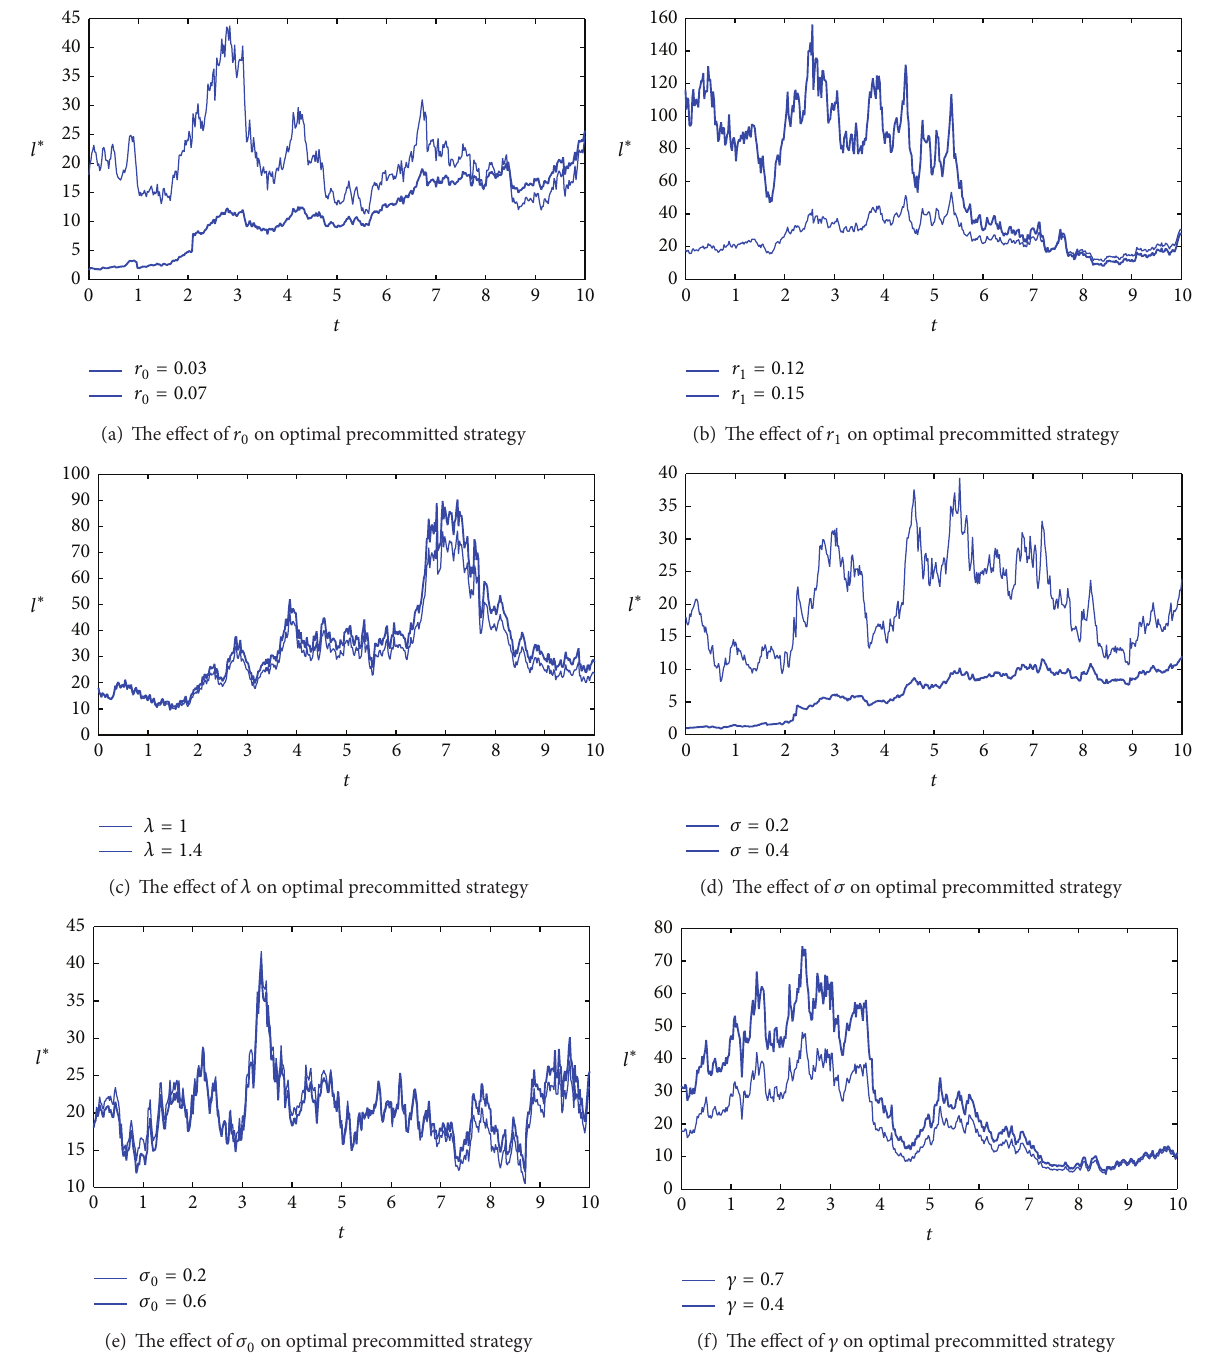
Figure 1: The effect of parameters on optimal precommitted strategy for the general risk